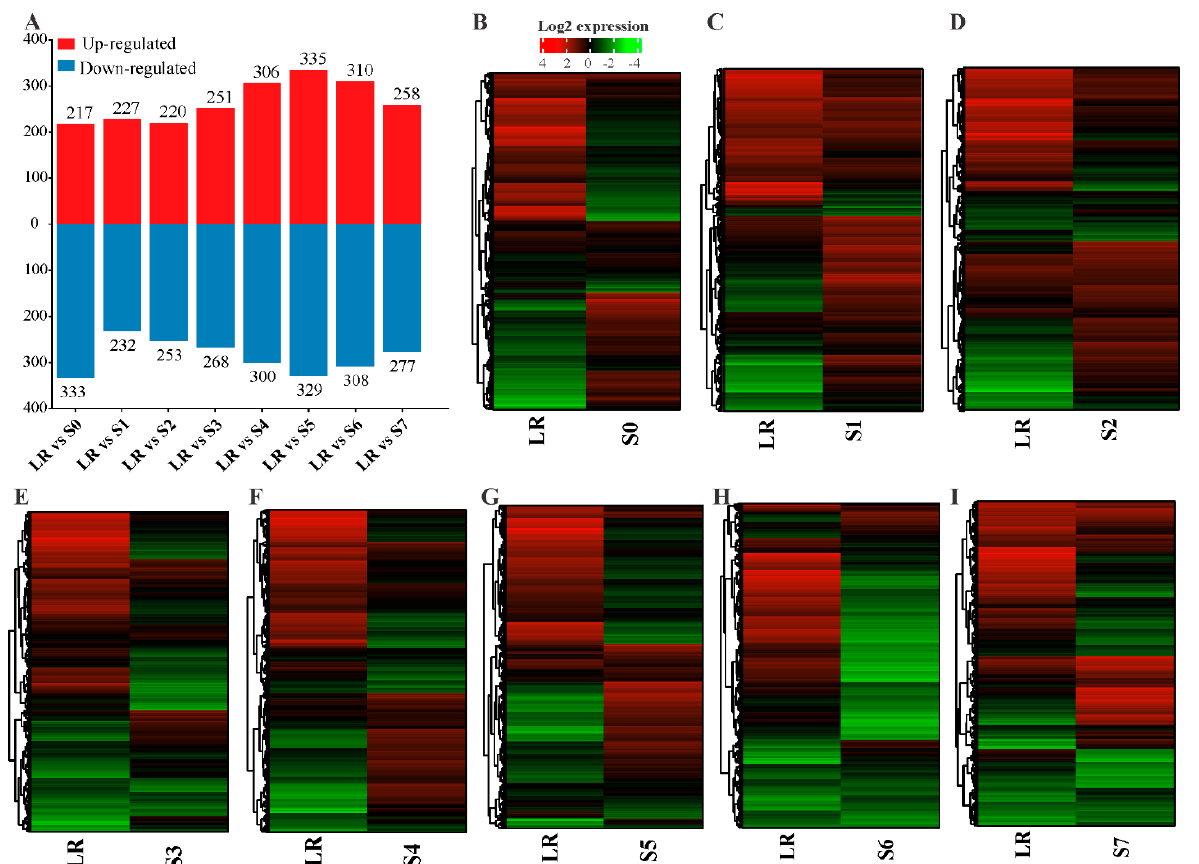
Figure 3. Number of differentially expressed lncRNAs (DE-lncRNAs) in different roots of white lupin. ( A ) Number of up and down-regulated genes in different root sections compared with LR, ( B ) DEGs heatmap of LR vs. S0, ( C ) LR vs. S1, ( D ) LR vs. S2, ( E ) LR vs. S3, ( F ) LR vs. S4, ( G ) LR vs. S5, ( H ) LR vs. S6, and ( I ) LR vs. S7. The red and green color represent up and down-regulation, while the black color shows no expression. LR, lateral root; S0–S7, different sections of white lupin roots.